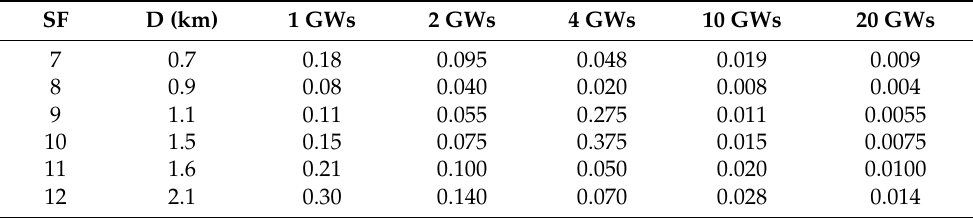
Table 6. Probability of ENs using